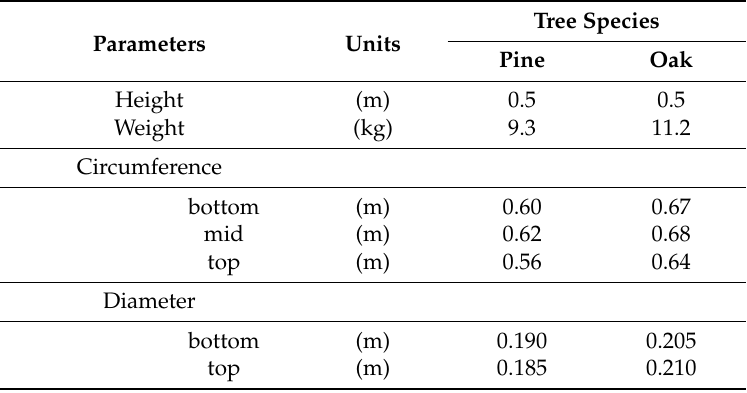
Table 1. Basic parameters of tree trunk samples used for